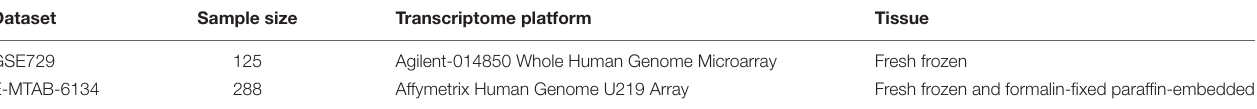
TABLE 2 | Information of the two publicly available independent validation